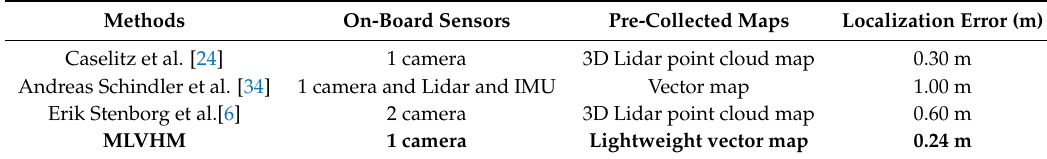
Table 4. Overall performance comparison with other